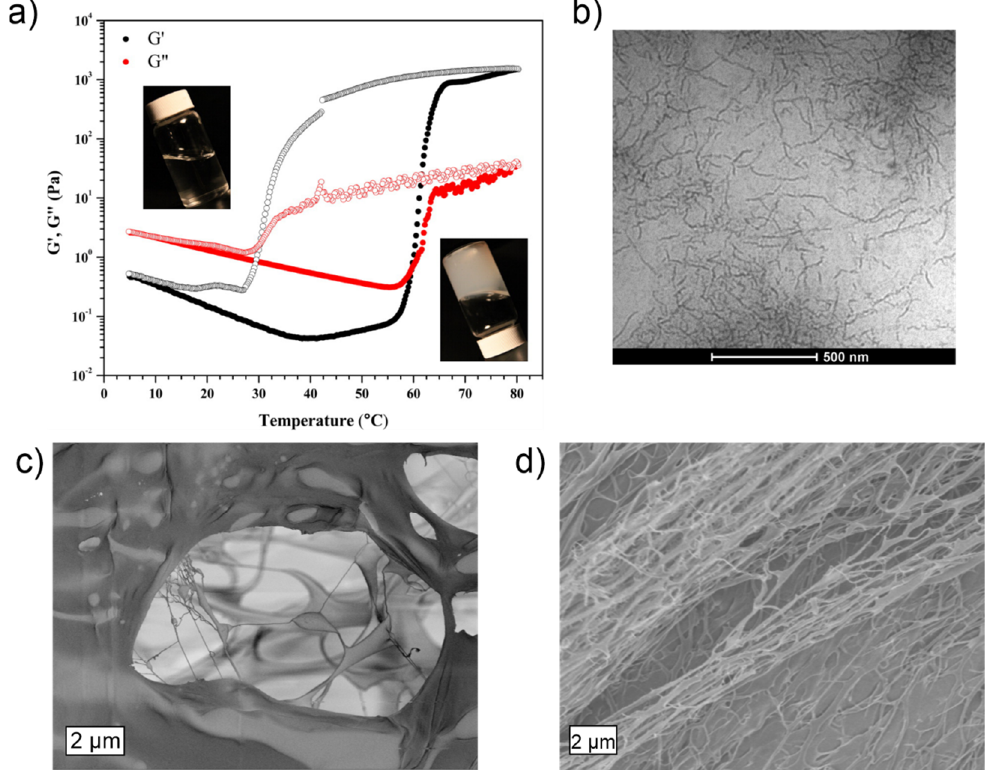
Figure 2. Thermoresponsive behavior of methylcellulose aqueous solution. ( a ) Development of storage (G ′ ; black) and loss (G ″ ; red) moduli of 1.4 wt% MC (molecular weight, MW 300,000) upon a heating (solid circles) and cooling (open circles) cycle. Insets show photographs of the sample at 25 °C and 75 °C. ( b ) Cryo-TEM image of 0.20 wt% MC solution (MW 300,000) above the LCST threshold reveals the fibrillar MC aggregates that form at elevated temperatures and facilitate gelation. ( c ) SEM micrograph of a 1% MC hydrogel freeze-dried from room temperature (ca. 22 °C) and then fractured. ( d ) SEM of a 1% MC hydrogel freeze-dried and fractured from 75 °C shows the enhanced presence of fibrillar structures. ( a , b ) adapted with permission from [57]. Copyright 2013 American Chemical Society. ( c , d ) adapted with permission from [31]. Copyright 2018 American Chemical Society.